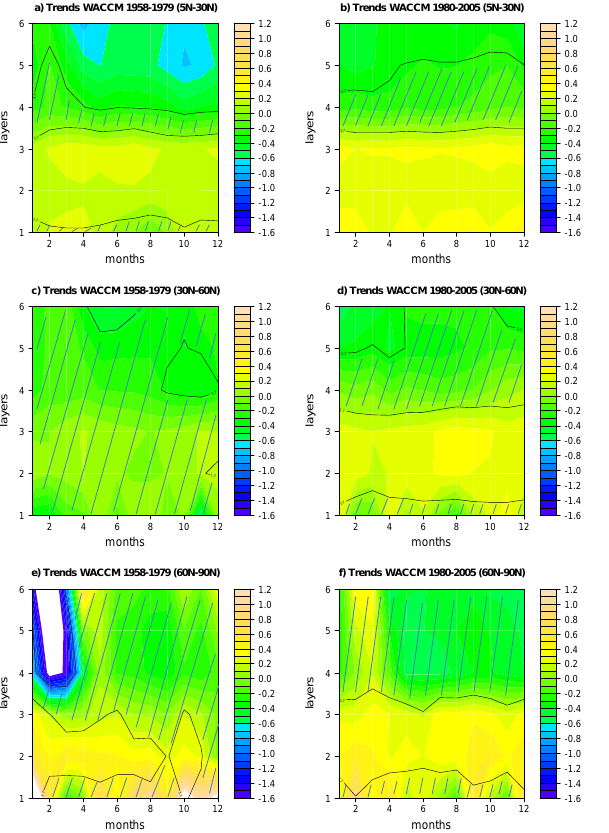
Figure 7 Figure 7. Correlation plots between tropopause pressure and layer mean temperature for each month ( x axis) and layer ( y axis) based on NCEP reanalysis (left panel) and WACCM model (right panel) over the common period 1958–2005 for the three latitudinal belts: 5–30 ◦ N ( a and d ), 30–60 ◦ N ( b and e ) and 60–90 ◦ N ( c and f ). Layer 1: 1000–925hPa, Layer 2: 925–500hPa, Layer 3: 500– 300hPa, Layer 4: 100–50hPa, Layer 5: 50–30hPa, and Layer 6: 30–10hPa. The contours indicate the statistically significant corre- lations at the 95% significance level with ρ >0.3 or ρ < −